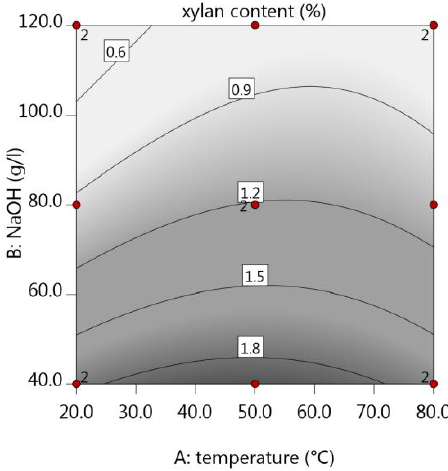
Figure 2. The xylan content of extracted sulphite pulp in correlation to temperature and NaOH concentration.